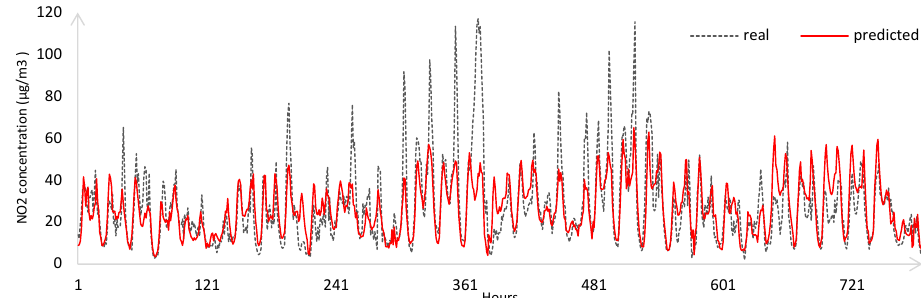
Figure 10. Real and predicted NO 2 , Sensor DETH043, September 2019, horizon: 120 h.